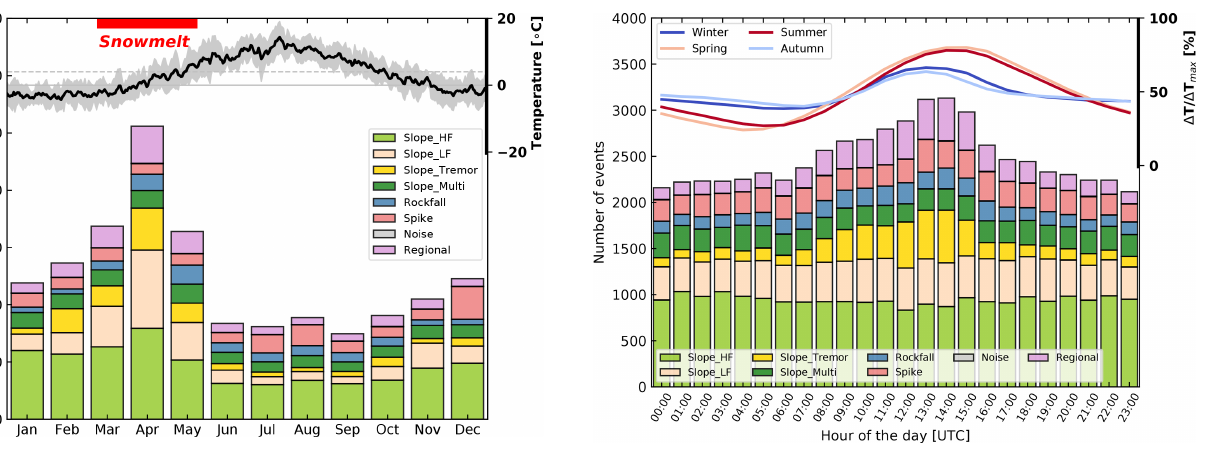
Figure 8. Distribution of detected events over hours of the day for 15 years of data (2007–2021). Left axis: number of events. Bars are subdivided into event classes; see legend of Fig. 7 for explanation. Top right axis: relative variations in temperature ( (cid:49)T/(cid:49)T max ) throughout the day, subdivided into seasons. For de- tails, see Fig.